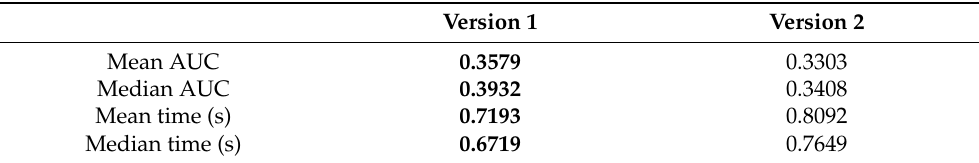
Table 6. AUC of the success rates per Pascal metric and processing time for DSFLA tracker with and without delimitation of the solution space (versions 1 and 2, respectively) (the best results are in